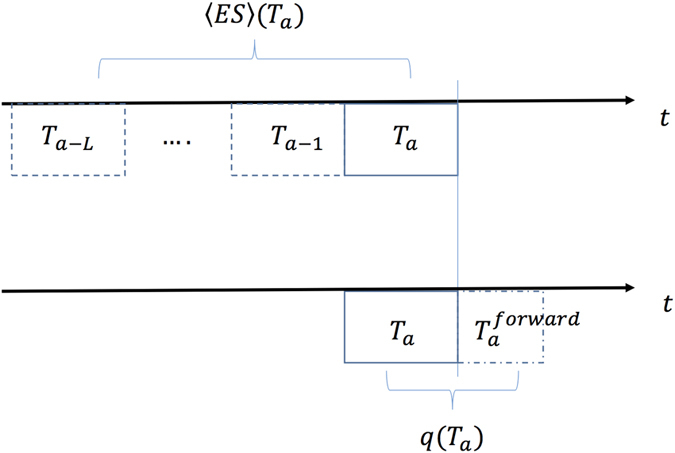
Scheme of time windows setting for 〈ES〉(Ta) and q(Ta) calculation.Ta is a window of length θ. The correlation structure persistence 〈ES〉(Ta) (upper axis) is computed by using data in Ta and in the first L time windows before Ta. The volatility ratio q(Ta) is computed by using data in Ta and in the future time window . In the upper axis the time windows are actually overlapping, but they are here represented as disjoint for the sake of simplicity.